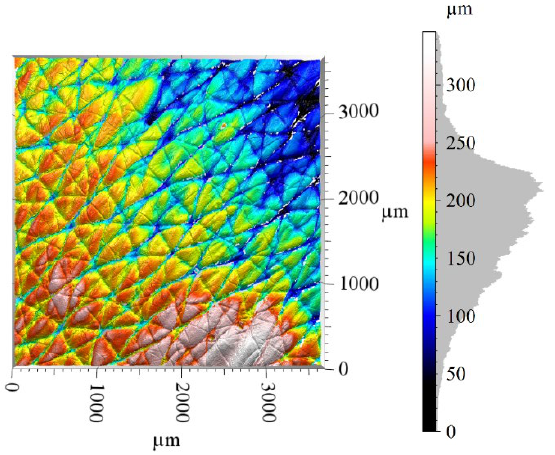
Figure 12. Three-dimensional view of the stitched topography in test case C. Stitching size: 5 × 5.